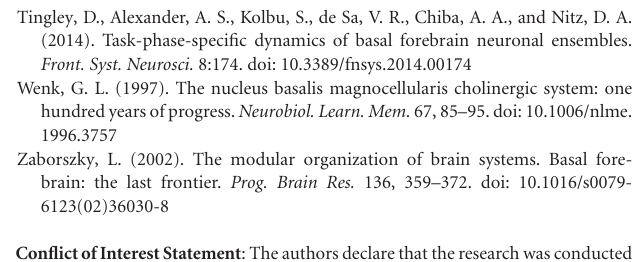
as a potential conflict of